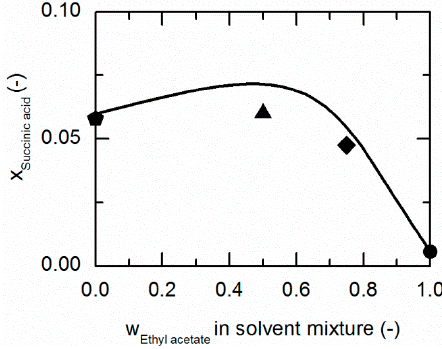
Figure 6. Solubility of succinic acid (SA) in ethanol/ethyl acetate mixtures at 310.15 K. The line correspond to the PC-SAFT prediction; symbols represent the experimental data points for SA in ethanol (pentagon), in the ethanol/ethyl acetate (solute-free) mixtures 0.5/0.5 w / w (up-pointing triangle), 0.25/0.75 w / w (diamond) and in ethyl acetate (circle).